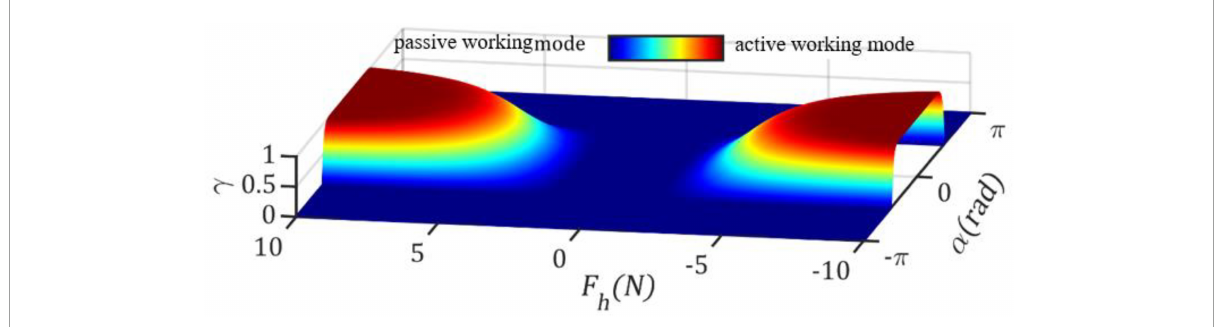
FIGURE2 Smooth transition of weight factor γ ( F h , α ) between 0 and 1. γ ( F h , α ) = 0 and γ ( F h , α ) = 0 correspond to passive and active working mode,